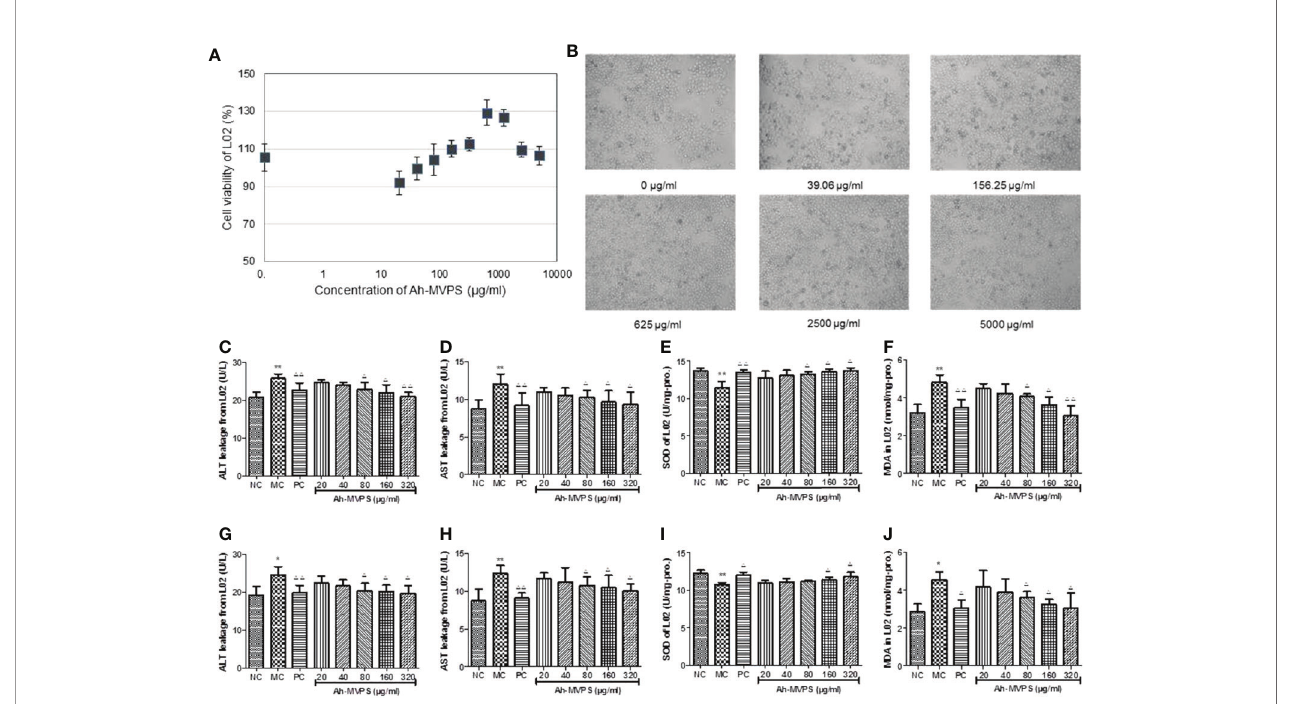
FIGURE 4 | Protection of Ah-MVPS against chemical damage to L-02 cell. The in fl uence of MVPS concentrations on L-02 cell viability and after 24h of co- incubation (A) , and optical images of L-02 incubated with MVPS (B) . Quantitation of leakage of ALT (serum alanine aminotransferase, C, G ) and AST (aspartate transaminase, D, H ), SOD (superoxidase dismutase, E, I ) activity, and MDA (malondialdehyde, F, J ) content for L-02 cells injured by H 2 O 2 and ethanol, respectively; *P< 0.05, **P < 0.01 vs. normal control (NC) set, D P < 0.05, DD P < 0.01 vs. model control (MC)